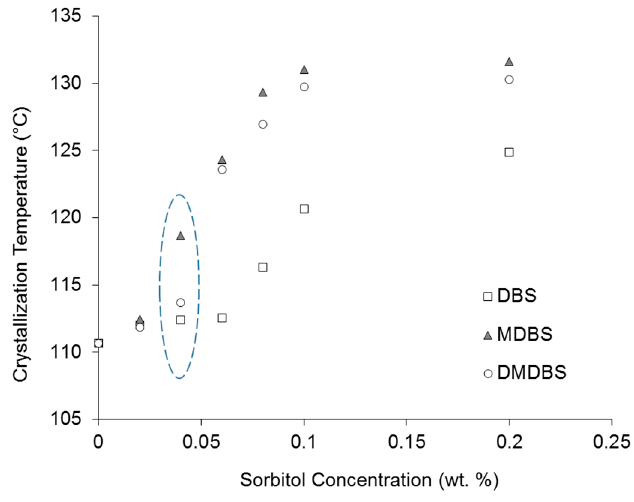
Figure 3. Efficiency of sorbitol nucleating effect in the iPP wax at the concentration of 0.02, 0.04, 0.06, 0.08, 0.1, and 0.2 wt. % of DBS, MDBS, and DMDBS.